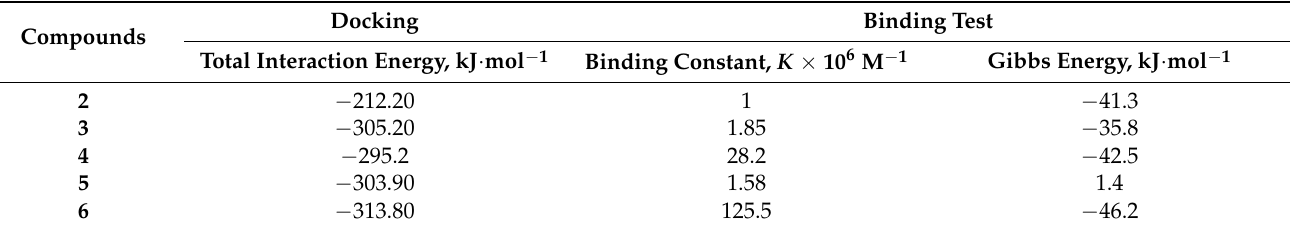
Table 1. Results of docking and DNA binding test for compounds 2 – 6